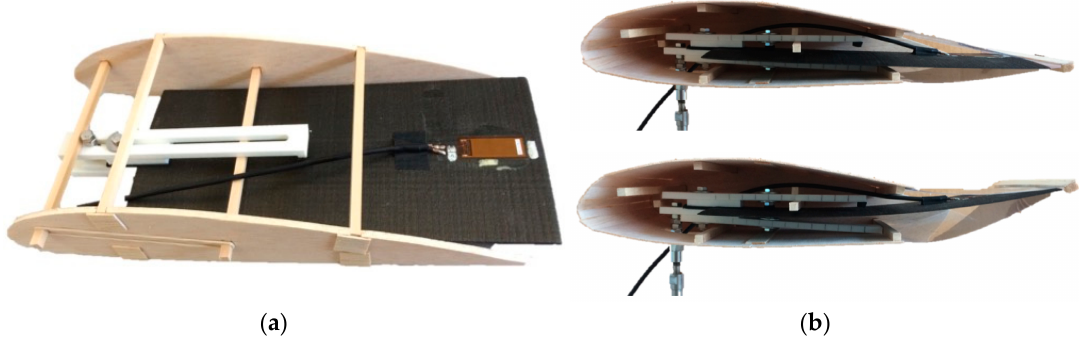
Figure 15. Experimental NACA 0011 airfoil ( a ) sample without the skin and ( b ) discrete mobile surface OFF (top) and ON (bottom).